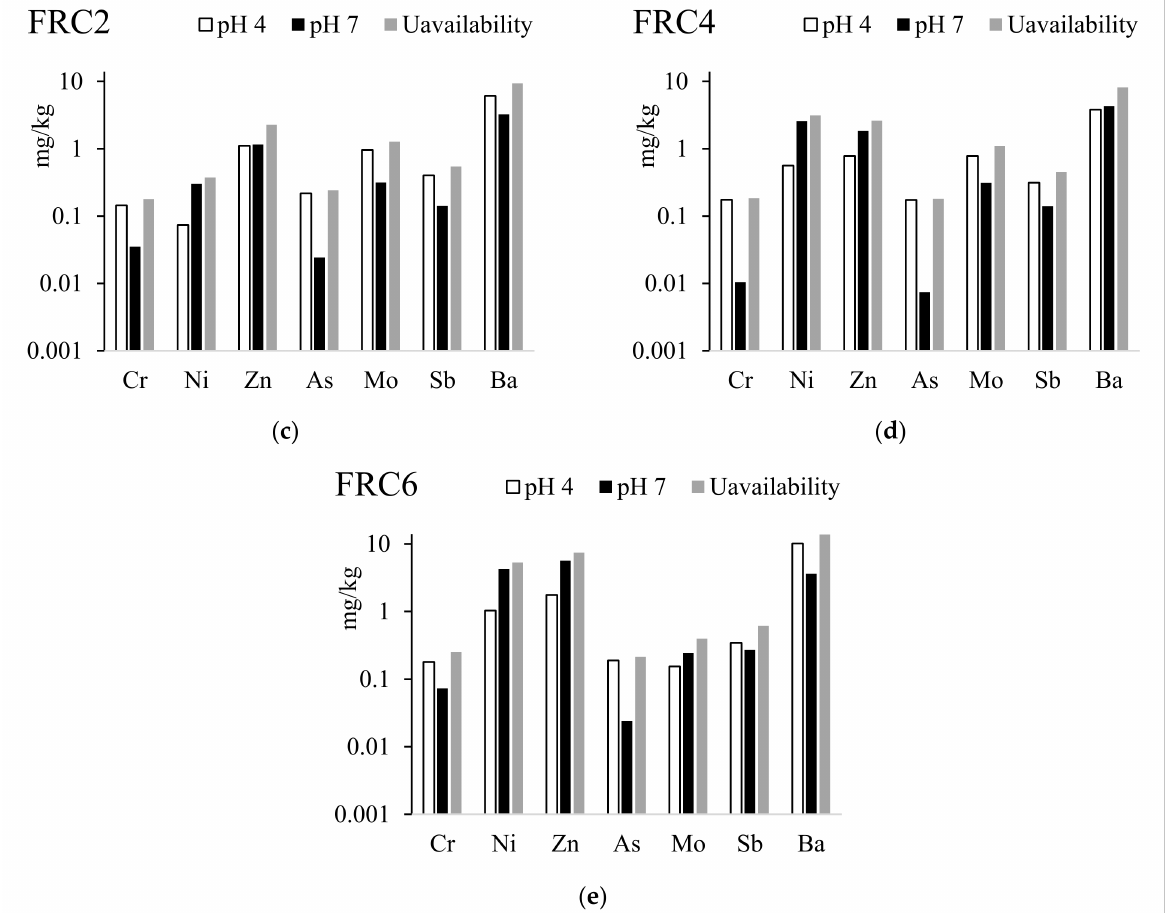
Figure 4. Comparison of two pH regimes in the availability test (pH 7 and pH 4) for heavy metals in samples: ( a ) control C-REF; ( b ) control FRC-REF; ( c ) FRC2 specimen; ( d ) FRC4 specimen; and ( e ) FRC6 specimen